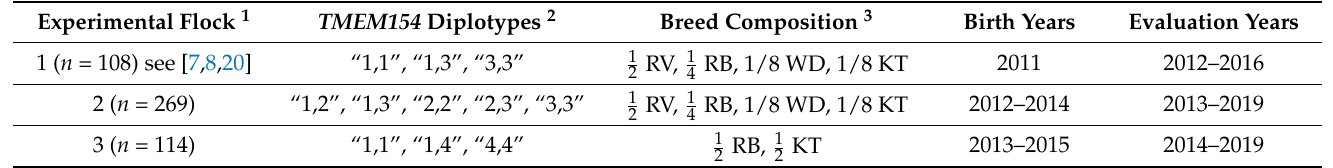
Table 1. Description of the three overlapping experimental evaluation ewe